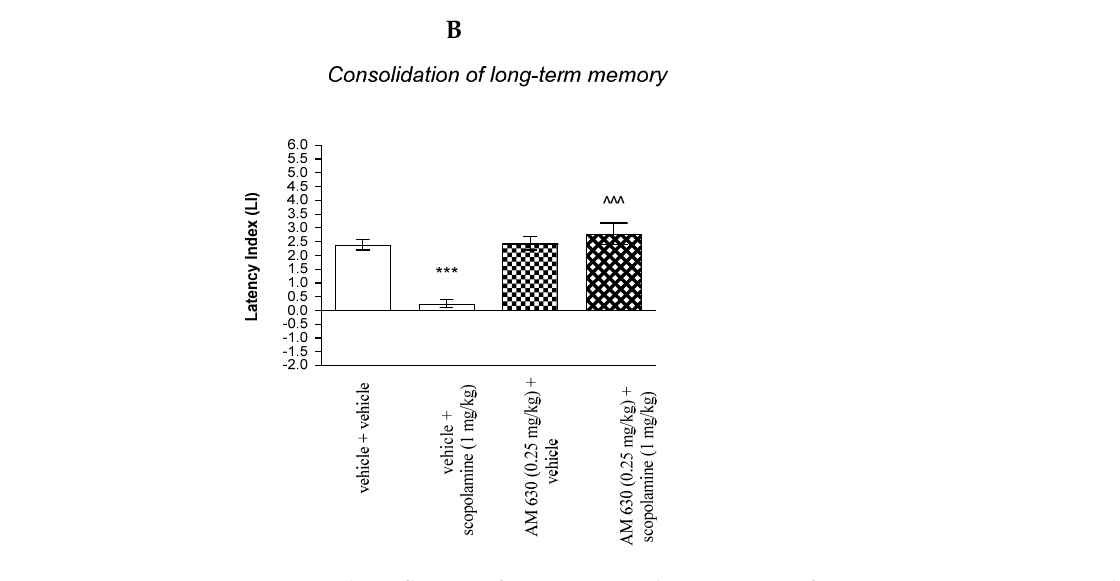
Figure 9. The influence of an acute co-administration of CB2-receptor antagonist and effective (amnestic) dose of scopolamine on the cognition-related responses expressed as latency index (LI) during the acquisition ( A ) and consolidation ( B ) of memory using the PA test in mice. *** p < 0.001 vs. vehicle/vehicle-treated mice; ˆˆˆ p < 0.001 vs. vehicle/scopolamine (1 mg/kg)-treated mice; & p < 0.05 vs. AM 630 (0.25 mg/kg)/vehicle ‐ treated mice.